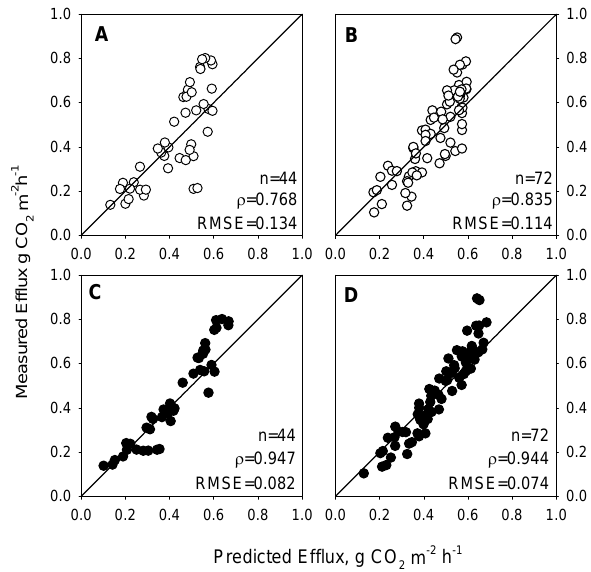
Fig. 7. Predicted versus measured efflux in evaluation data in 2000. (A) Predicted efflux in Huhus in 2000 with the quadratic soil temperature model. (B) Predicted efflux in Mekrijärvi in 2000 with the quadratic soil temperature model. (C) Predicted efflux in Huhus in 2000 with the quadratic soil temperature and degree days model. (D) Predicted efflux in Mekrijärvi in 2000 with the quadratic soil temperature and degree days model. Models formu- lated as LnFlux = b 0 + b 1 × T soil + b 2 × T 2 and LnFlux = b 0 + soil b 1 × T soil + b 2 × T 2 + b 3 × degree_days + b 4 × degree_days 2 soil